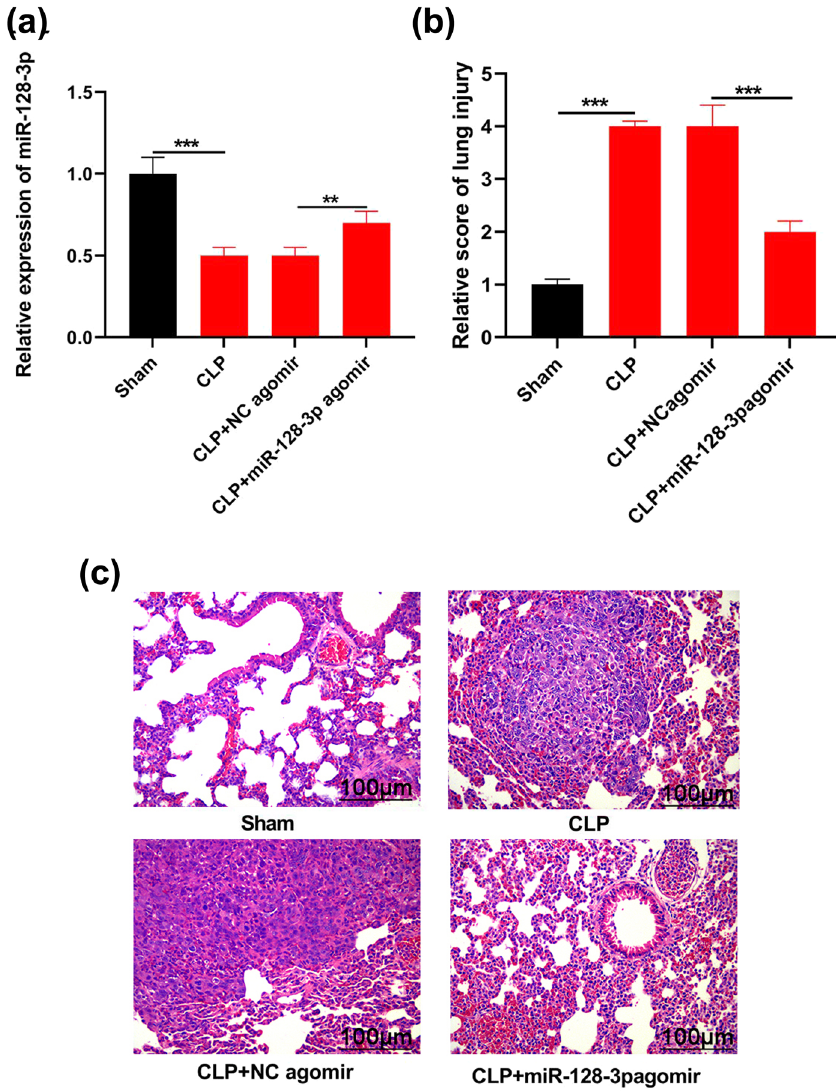
Figure 1: miR - 128 - 3p expression on lung of mice models of sepsis due to CLP and miR - 128 - 3p over - expression to lung damage as a result of sepsis. ( a ) RT - qPCR detected miR - 128 - 3p level. ( b ) Measured score of lung damage on tissues with high miR - 128 - 3p expression. ( c ) H & E staining tested the degree of lung damage in tissues with high miR - 128 - 3p expression. ** P < 0.01, *** P <